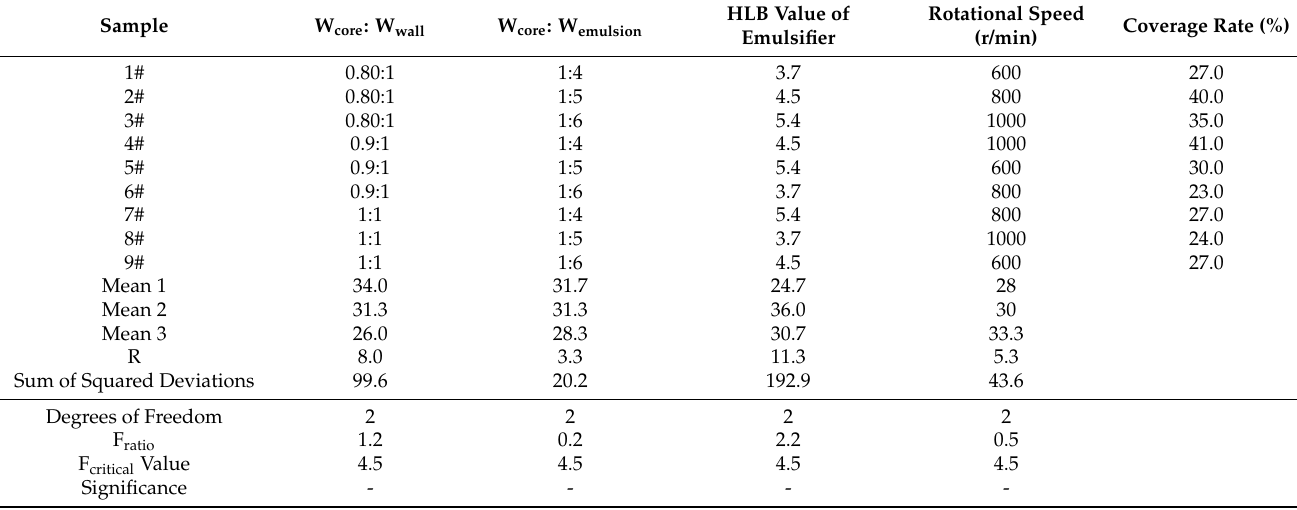
Table 5. Orthogonal experiment results for coverage rate.